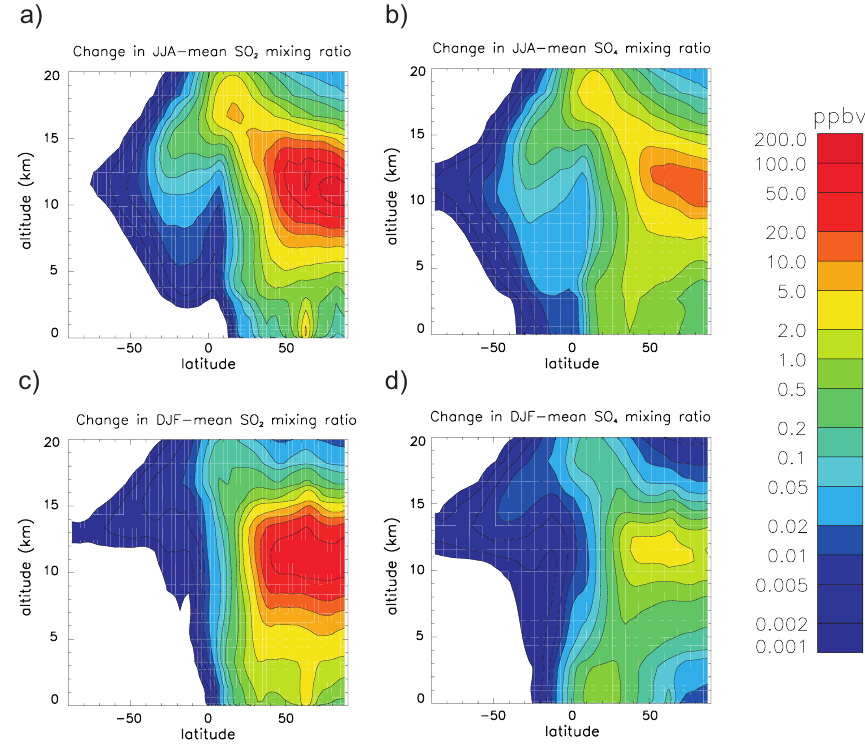
Fig. 2. Simulated changes (i.e. perturbed minus unperturbed) in zonal 3-month mean SO 2 and SO 4 aerosol mixing ratios in parts per billion by volume (ppbv) for L-s ( a and b ) and L-w ( c and d ). JJA=June-July-August;